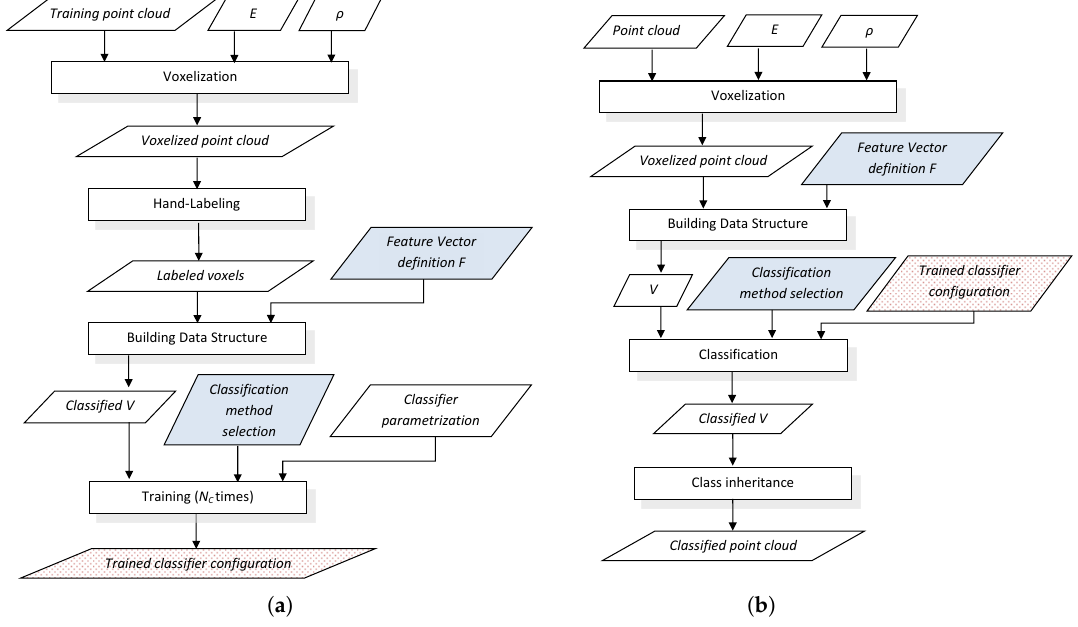
Figure 1. Offline training ( a ) and online classification ( b ) procedures with voxel-based neighborhood computation. The choices of a feature definition and a classification method are common for both procedures (shaded in solid blue). The trained classifier configuration (shaded in dotted red) output in ( a ) is used in ( b